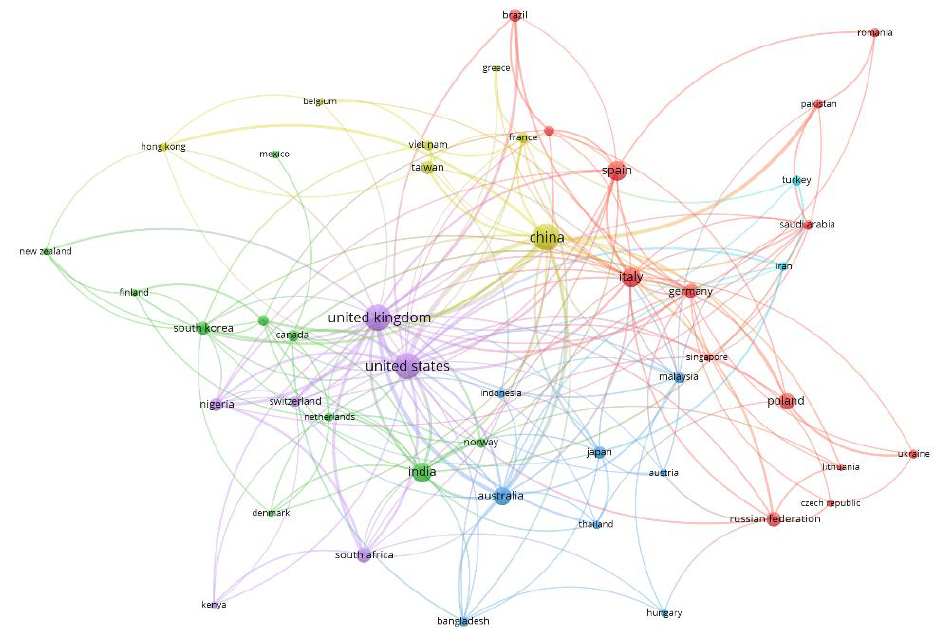
Figure 6. Network of cooperation between countries based on the co-authorship of articles.